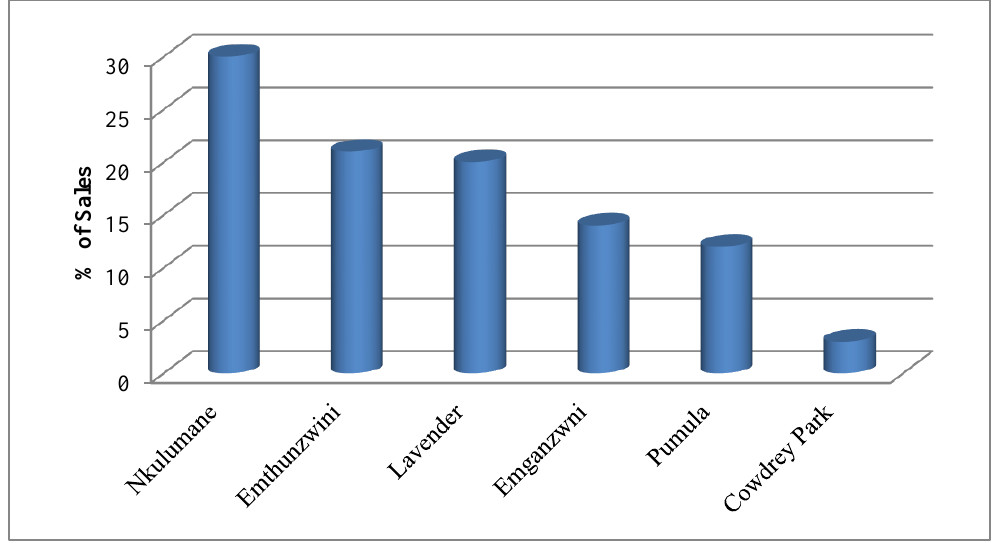
Fig. 2. Property sales in different residential areas of Bulawayo (developed by the